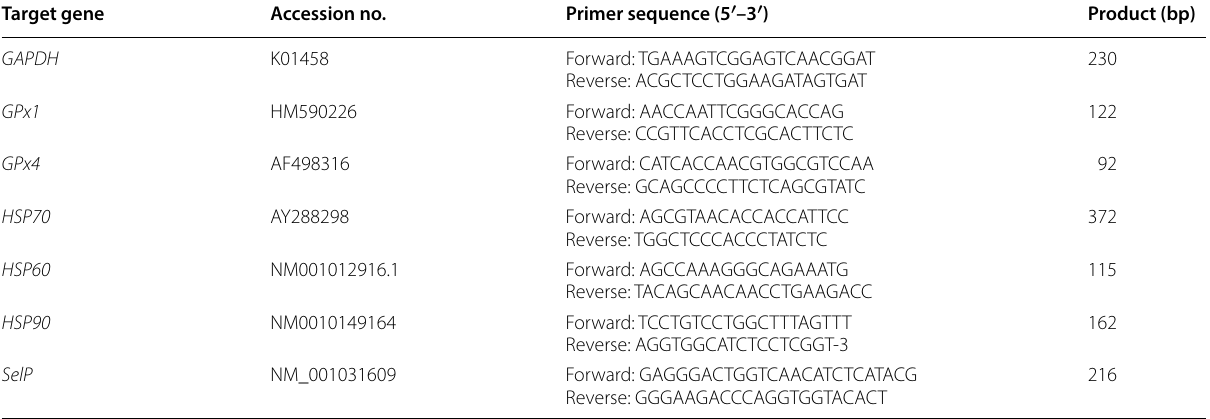
Table 2 Primers used for real-time PCR Target